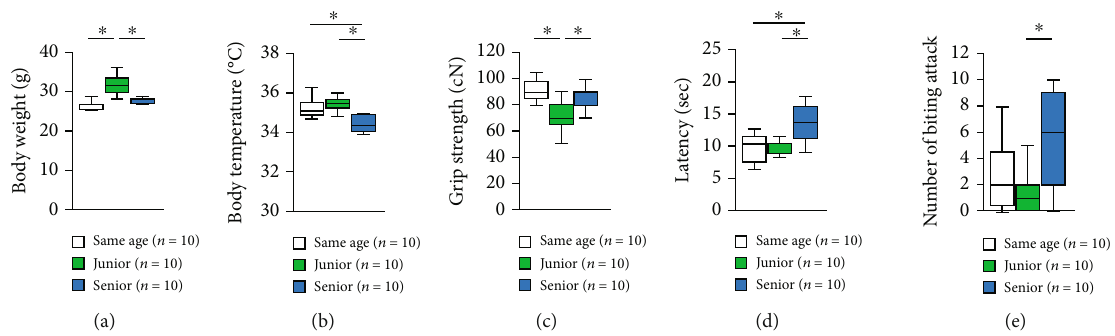
Figure 1: E ff ect of group housing condition on normal physical characteristics and aggressive behaviors. (a) Body weight. (b) Body temperature. (c) Grip strength. (d) Hot plate test. (e) Number of biting attacks on the cotton bud. All data are presented as box plots. ∗ Signi fi cant di ff erence in comparison between groups ( p < 0 : 05 ). The p values were calculated by using two-way